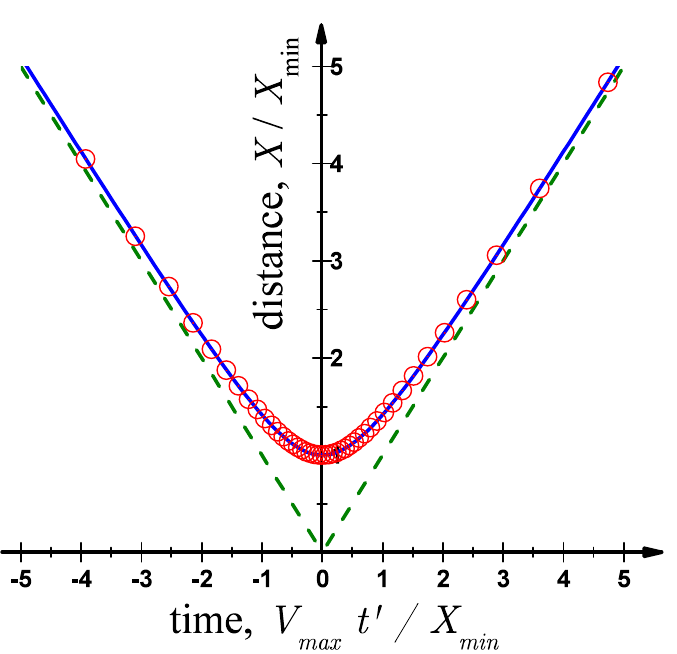
Figure 9. Distance of the heavy ball close to the return point, for b = 2 and N = 3. Circles, heavy ball X ; dashed line, limit of an infinitely massive ball, Equation (44); solid line, hyperbola defined by Equation